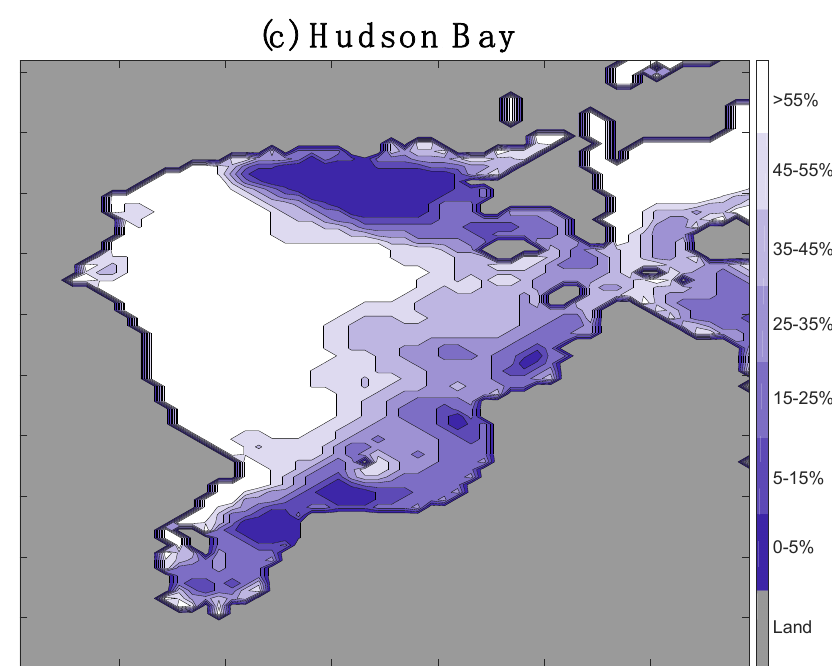
Figure 1. Binned June 2017 sea ice concentration (SIC) observations for the ( a ) Arctic region, ( b ) Chukchi Sea, and ( c ) Hudson Bay. The upper red dashed box in ( a ) indicates the Chukchi Sea subregion displayed in ( b ) and the lower red dashed box highlights the Hudson Bay subregion displayed in ( c ).